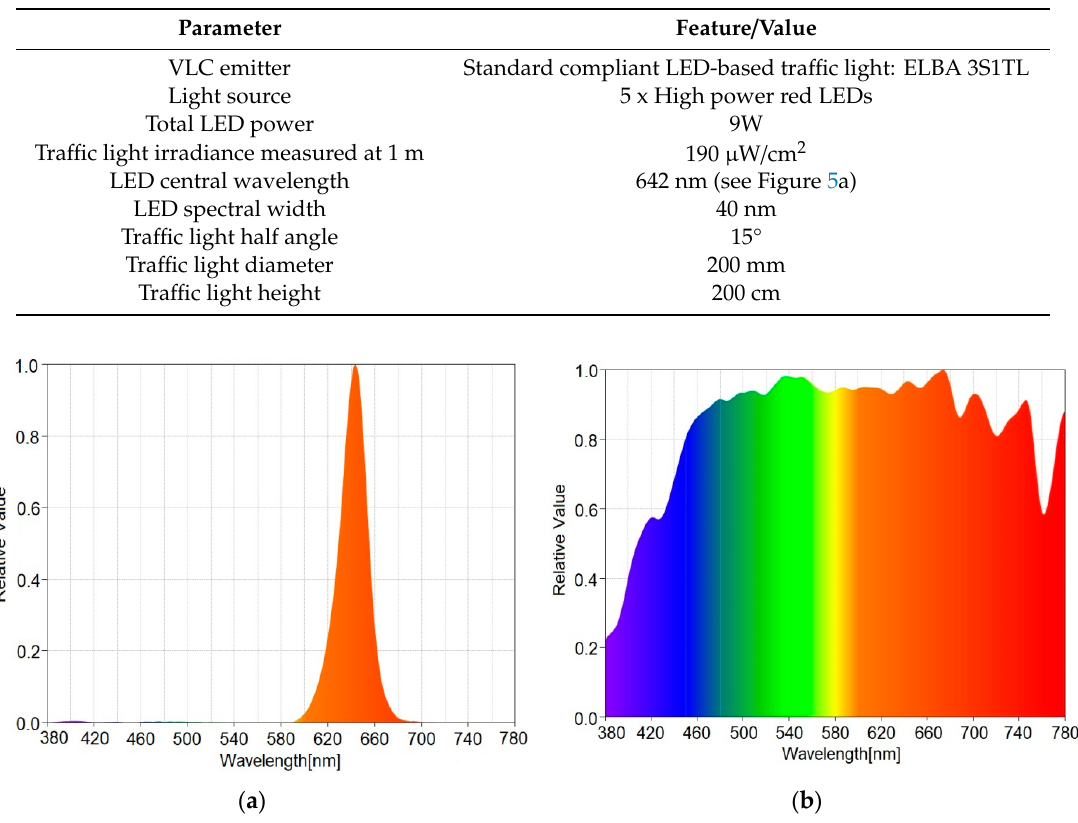
Figure 5. ( a ) LED tra ffi c light spectral analysis; ( b ) Sunlight spectral analysis during the tests.